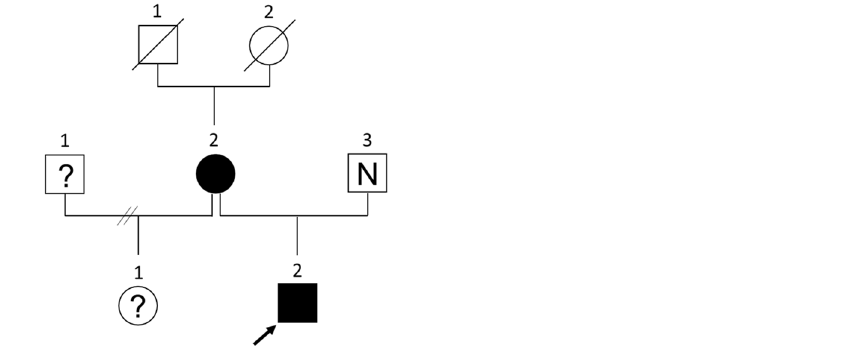
Figure 1. Pedigree of the family. Squares or circles with ‘‘?’’ denote individuals whose genotype information is not available. Dark squares or circles denote affected individuals. Square with ‘‘N’’ denotes the individual with a normal karyotype. The grandfather (I-1) and grandmother (I-2) of the child are deceased. The mother (II-2) with her previous husband (II-1) has one daughter (III-1), but they are not available for clinical or genetic testing. The arrow represents the child (III-2), who harbors the same complex chromosomal alterations as his mother. The father (II-3) has a normal karyotype.